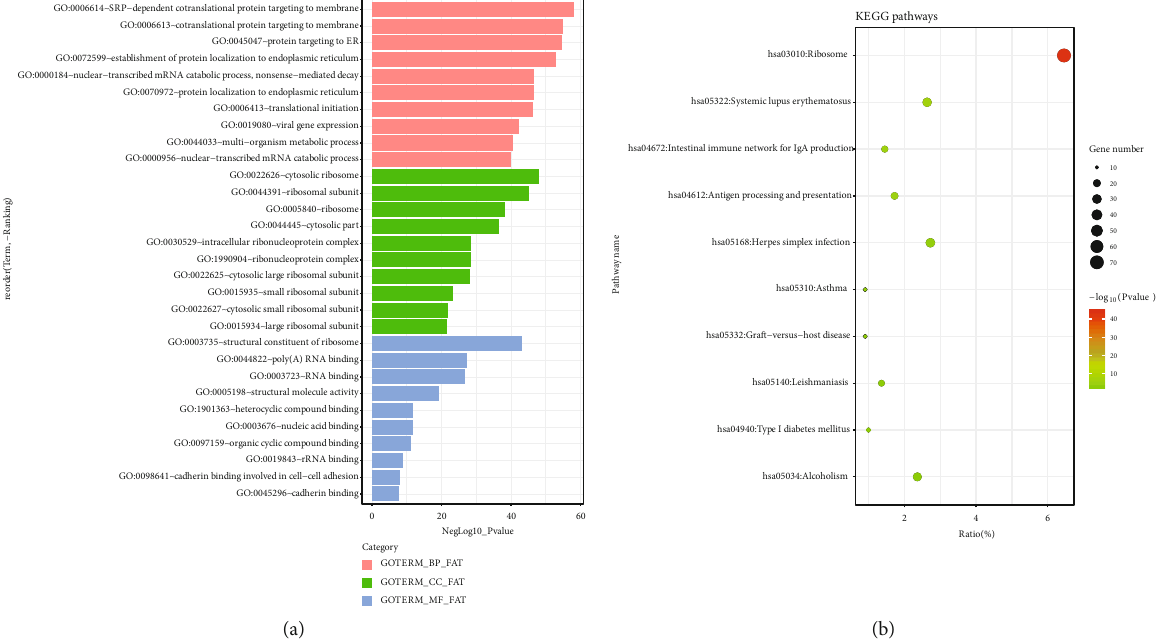
Figure 2: Enrichment analysis of DEGs. (a) Gene ontologies and DEGs; (b) Kyoto Encyclopedia of Genes and Genomes enrichment of DEGs.